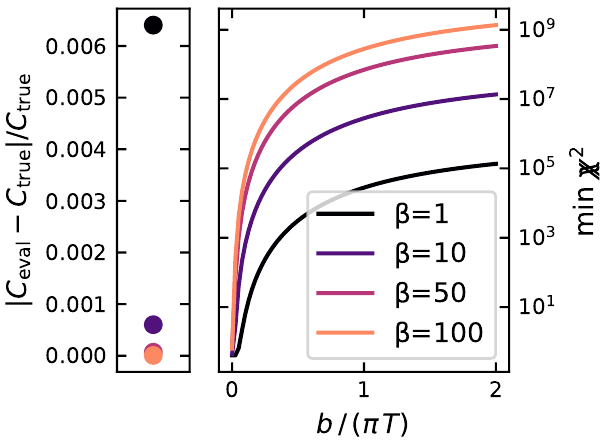
Figure 8: Left: Comparison of QMC-data with χ th Right: MaxEnt results compared to evaluating Eq. (56) for the fit parameters obtained from fitting Eq. (58).